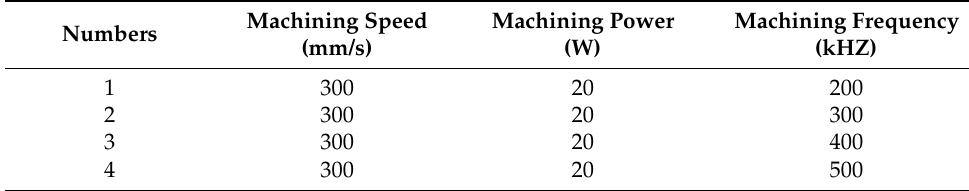
Table 5. Process parameters of laser